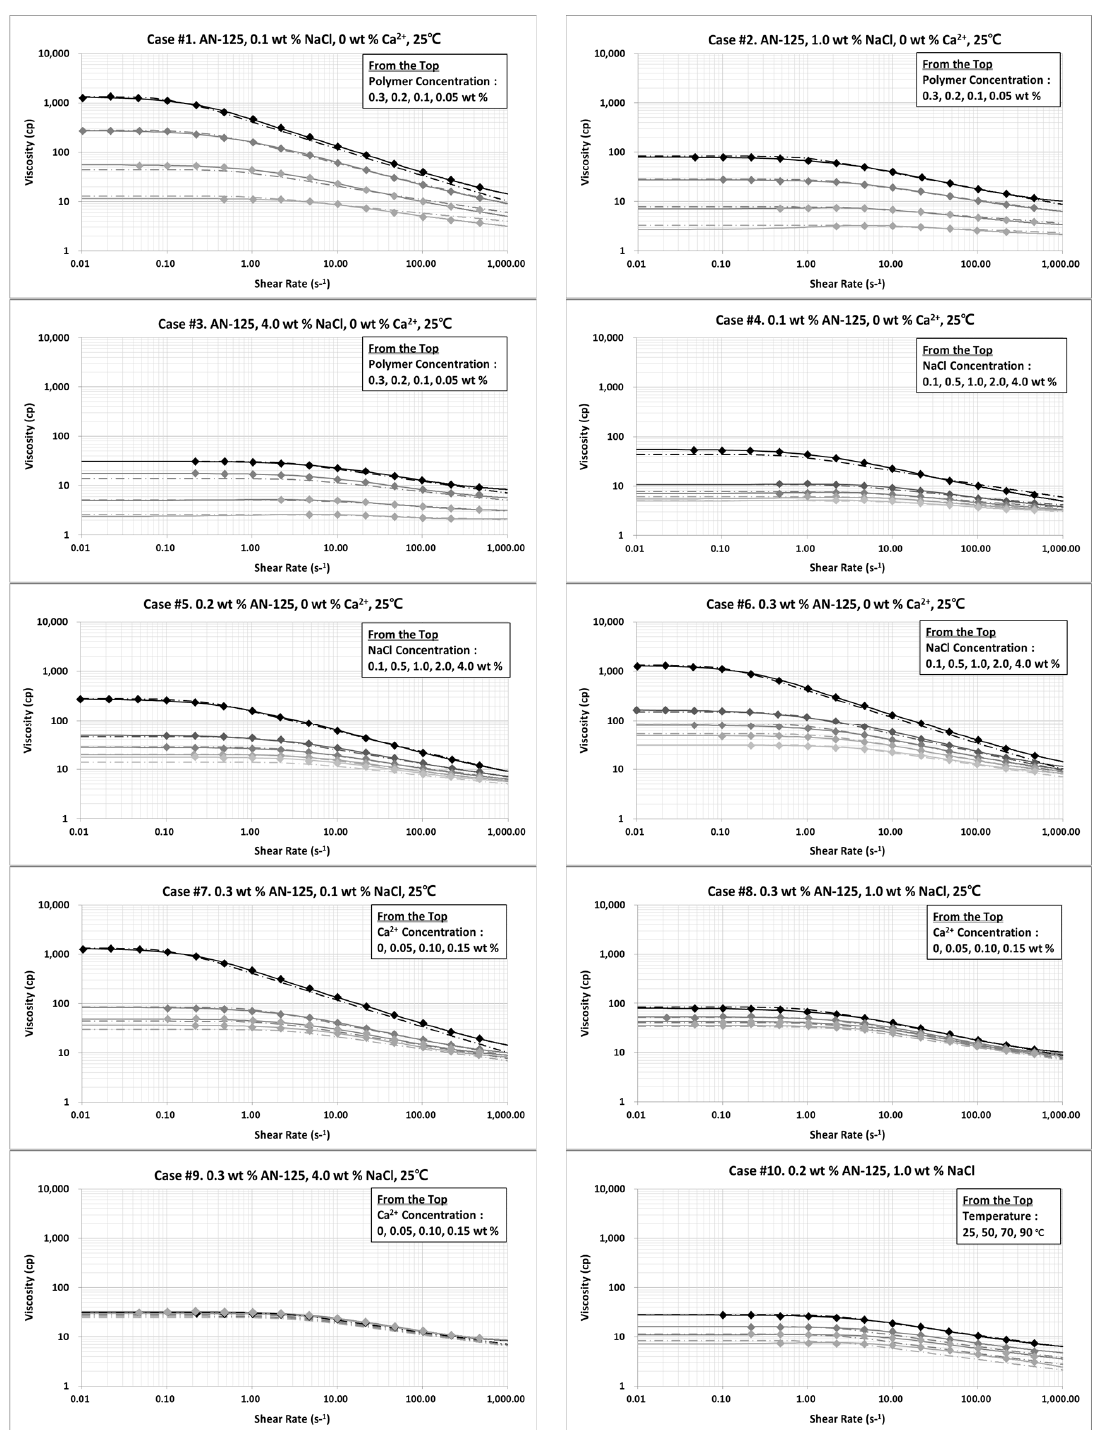
Figure 9. Comparison between the measured and estimated viscosities of Flopaam TM 3630S. Line, viscosity estimated by the ANN model; dot, measured viscosity; dotted line, viscosity estimated by the Carreau model using Lee’s correlation.